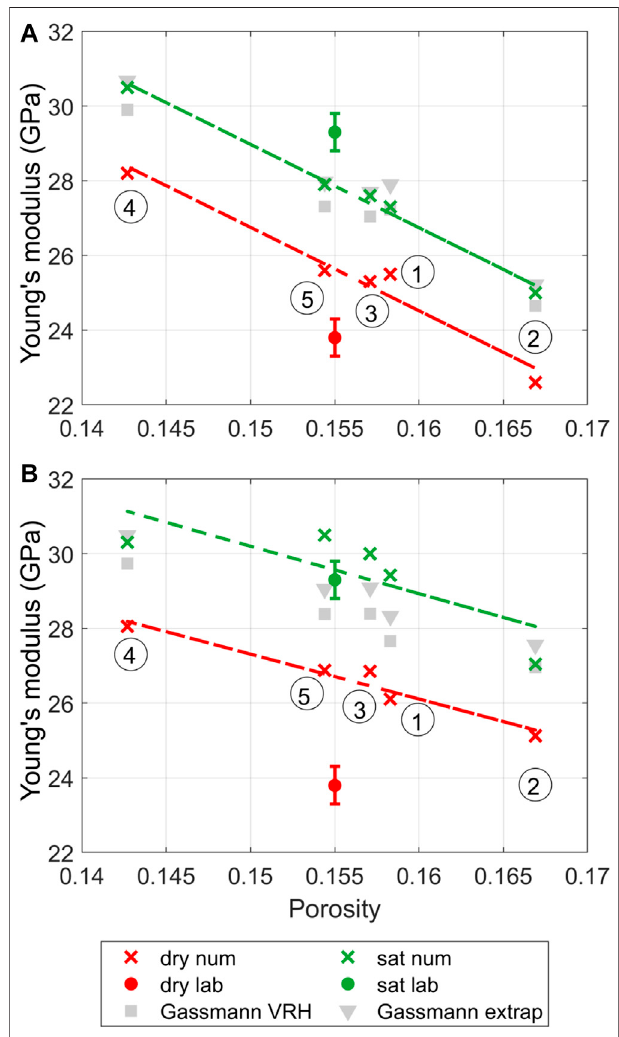
FIGURE 9 | The comparison between the laboratory-measured and the numerical simulated Young ’ s modulus. Here, we show the result from two scenario: simulation with aspect ratio of 0.4 (A) and aspect ratio if 0.5 (B) . The drycaseand the100%water-saturatedcase arerepresented inred and green, respectively. Five numerical simulations on sub-volumes are shown with the cross symbol, and the sub-volume numbers are labeled next to the cross symbol. We fi t the fi rst-order polynomial through the numerical simulation results, observing a decreasing trend between the Young ’ s modulusandtheporosity.Thegraytriangleandsquaresymbolsrepresentthe estimated Young ’ s modulus using Gassmann ’ s equation. The mineral modulus is approximated with the linear extrapolation of the sub-volume modulus (triangle symbols) and the Voight-Reuss-Hill average (square